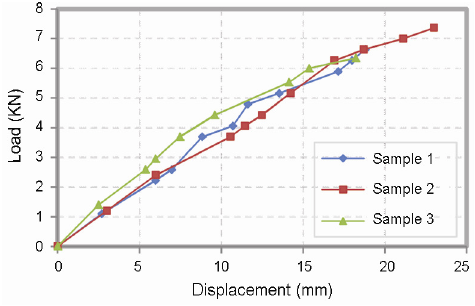
Fig. 11. Load-displacement curves for FRP-strengthened speci- mens with one layer of GFRP and with diagonal grooves